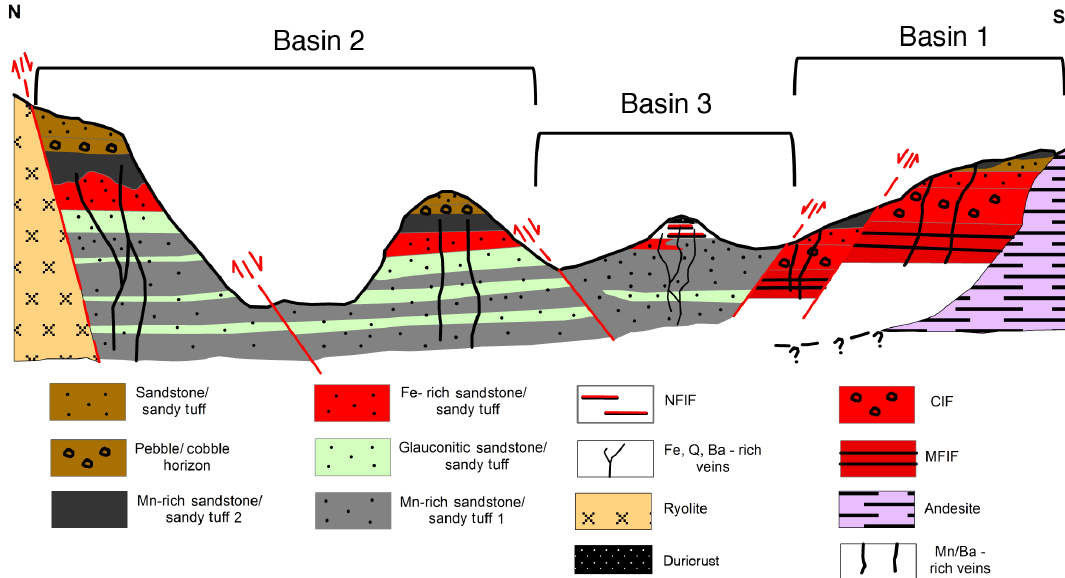
Figure 2. A generalized north–south stratigraphic map of the ∼ 1km long CVSB showing interpreted geology, lithology, and main faults and how they relate to the iron and manganese formations, in support of a three-basin hypothesis. Not drawn to scale. Four types of iron-rich sedimentary rocks occur in the CVSB. These include the iron-rich sandstones, the iron-Mn-rich sandstones, the CIF, and the MFIF and NFIF formations that are depositionally and chemically distinct from the sandstone